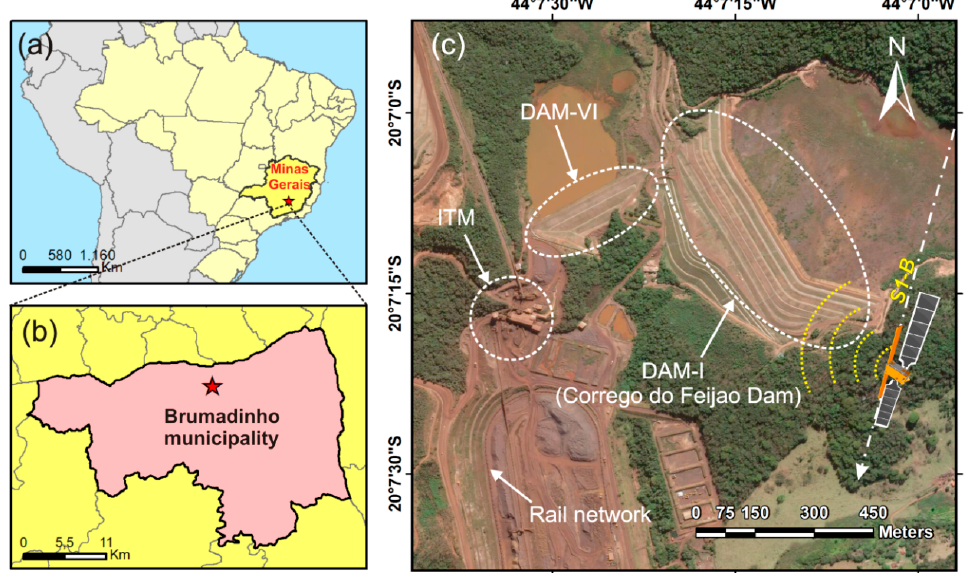
Figure 1. ( a ) Study area location in Minas Gerais state / Brazil; ( b ) Location of Paraopeba Iron Complex in the Brumadinho municipality; ( c ) Paraopeba Iron Complex showing tailings Dam I and hydric Dam VI, ancillary mining structures such as ore treatment installation (ITM), rail network, access roads, and a Sentinel-1B descending orbit ground track.